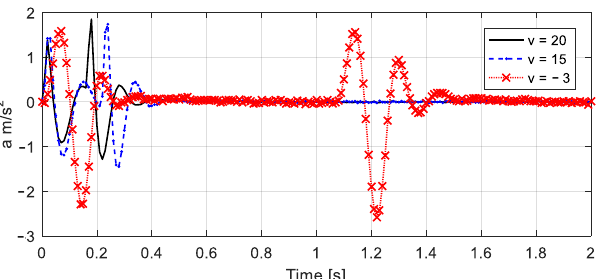
Figure 8. The accelerations of the vehicle body measured by S 1 with velocities of [20, 15, − 3] m/s.